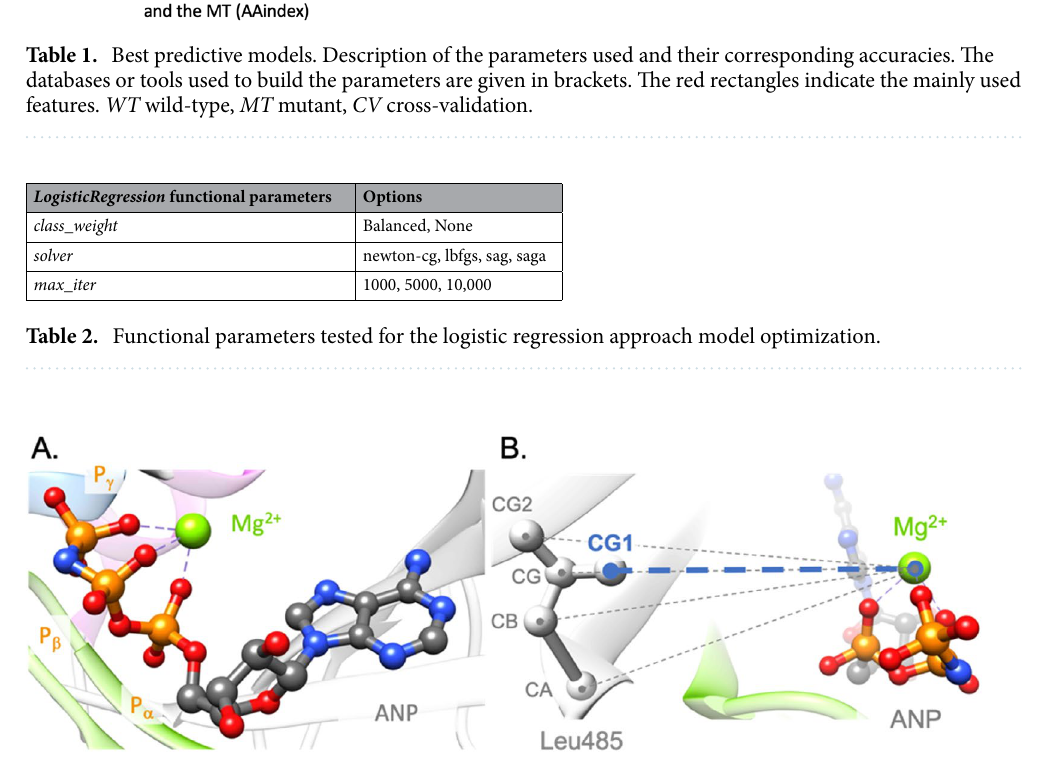
Figure 5. Key atoms and distances. ( A ) Representation of the key atoms selected for distance calculations, which are the Mg 2+ , and Pα, Pβ and Pγ from the ANP; ( B ) Example of the distance calculation between heavy atoms of Leu485 and Mg 2+ . The shortest distance, which will be used in our predictive model, is the one between atoms CG1 and Mg 2+ . ANP and Leu485 are represented in gray ball and stick, the Mg 2+ in a green sphere and the protein in ribbons (pdb code: 6pp9) 12